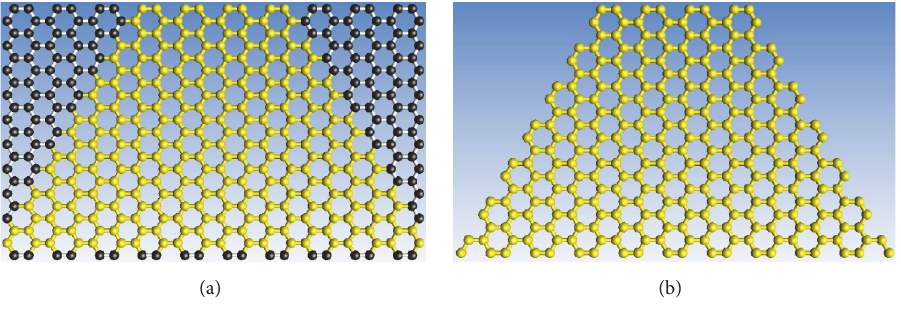
Figure 5: Personalized tailoring for graphene.